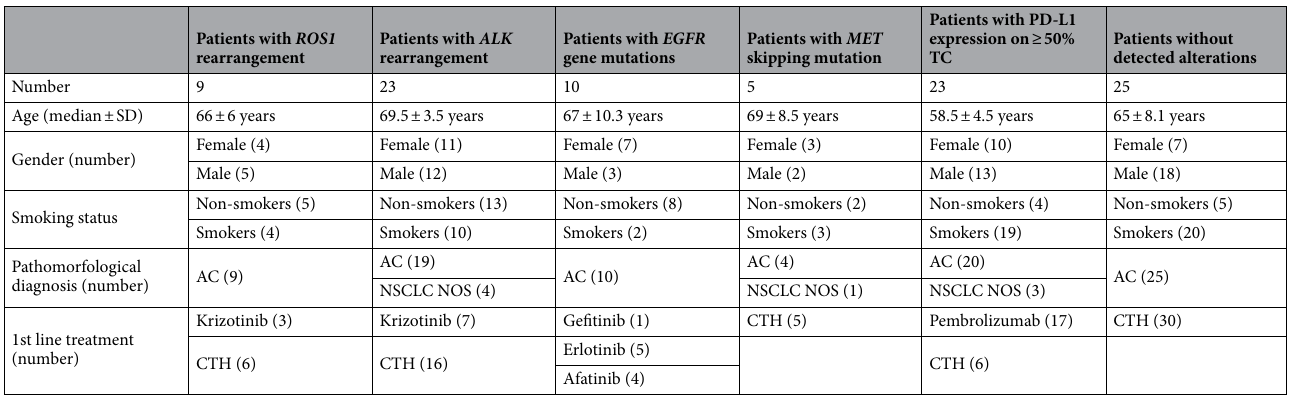
Table 3. Patients characteristics (SD—standard deviation, AC—adenocarcinoma, NSCLC NOS—non-small cell lung cancer not otherwise specified,